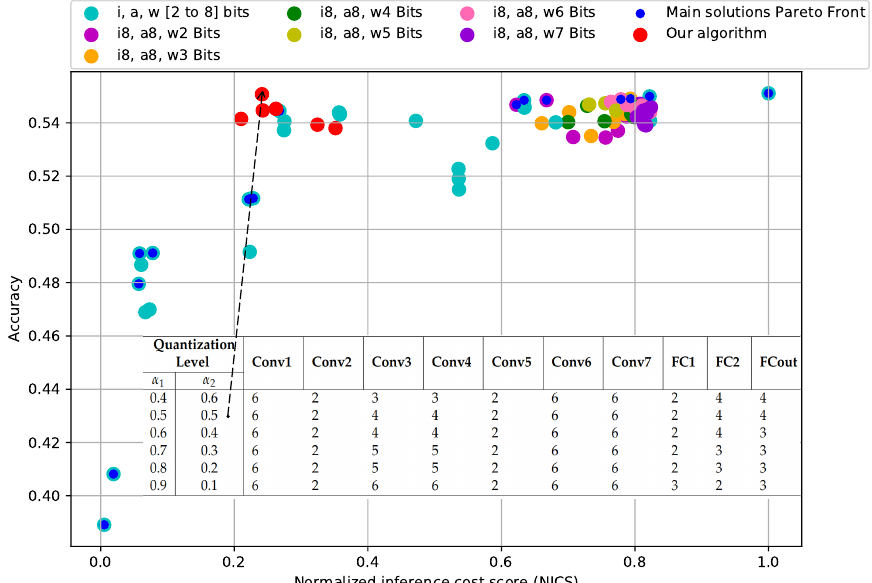
Figure 7. Configurations obtained following the proposed methodology (in red). The solutions obtained in previous phases are also shown. Notice that by varying α 1 and α 2 , different configurations can be obtained that were not found in the initial experimentation analyzed with the Pareto